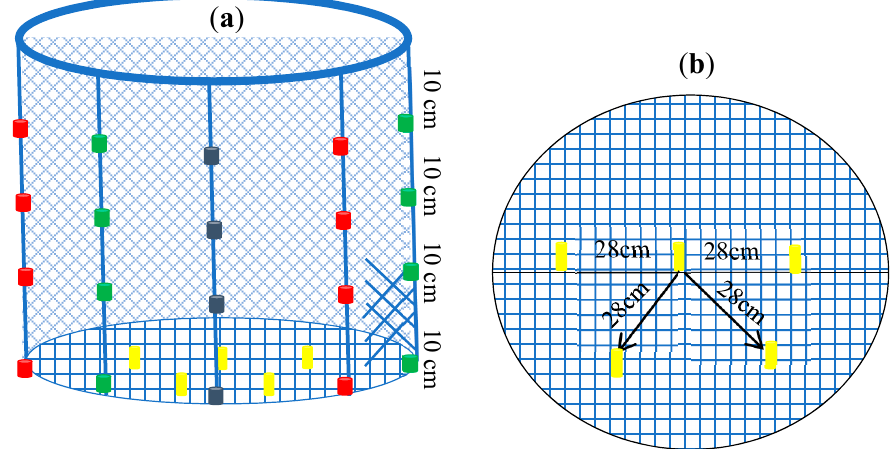
Figure 4. Placement of light-emitting diode (LED) markers on the side and bottom netting. ( a ) Side and ( b ) bottom nettings.